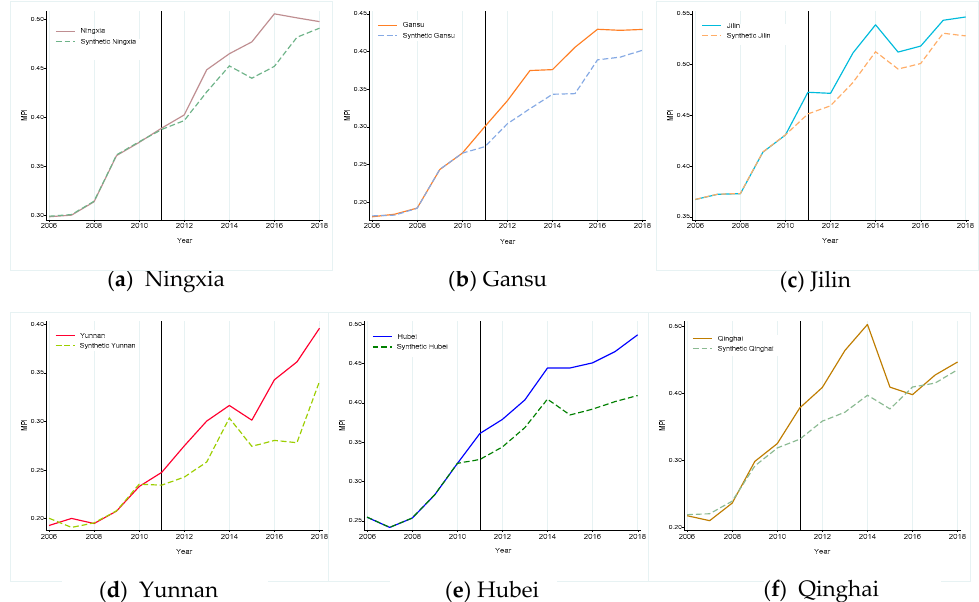
Figure 3. Comparison of MPI in the observed provinces and synthetic provinces from 2006 to 2018. Note: The black vertical solid line represents the opening of TPEFAP, the dashed curve is a synthetic MPI, and the solid curve is the actual MPI, the same below.